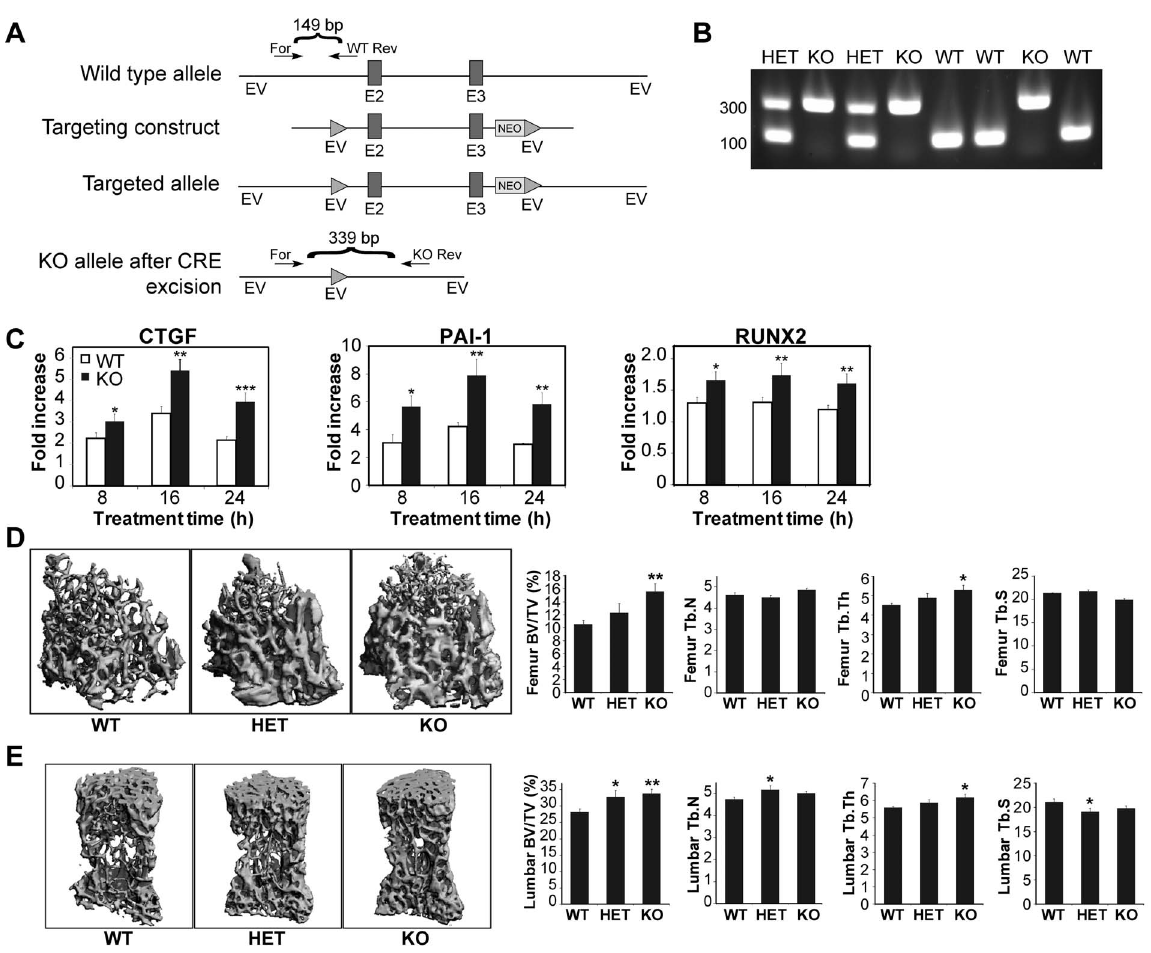
Figure 4. The invivo effects of loss of HTRA1. ( A ) Schematic of the HTRA1 knockout strategy. Primers were designed with one forward primer (For) that amplifies an amplicon for the wild type and heterozygous alleles with a corresponding reverse primer (Rev), and a second reverse primer designed to only amplify the knockout. The knockout reverse primer (KO Rev) only amplifies following CRE-LOX recombination. Solid triangles=loxP sites; EV=EcoRI. E2=Exon2; E3=Exon3. ( B ) Genotype results of mouse embryonic fibroblasts showing confirmation of the generation of HTRA1 + / 2 and HTRA1 2 / 2 mice. ( C ) Expression of TGF- b -regulated genes in embryonic fibroblasts from wild type (WT) and HTRA1 knockout (KO) mice. Cells were treated with 1 ng/ml TGF- b for the indicated times. * P , 0.05, ** P , 0.01, *** P , 0.001, Student’s t -test, n=9 for each cell type. ( D ) Microcomputed tomography and parameters of trabecular bone in the distal femurs in wild type (WT), HTRA1 heterozygous (HET) and HTRA1 knockout (KO) mice (all males, 3 months old). ( E ) Microcomputed tomography and parameters of trabecular bone in the fourth vertebrae in wild type (WT), HTRA1 heterozygous (HET) and HTRA1 knockout (KO) mice. For both ( D ) and ( E ), * P , 0.05, ** P , 0.01, *** P , 0.001, ANOVA and Fisher’s protected least significant difference test,